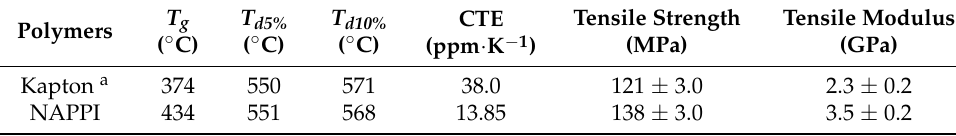
Figure 5. ( a ) Thermogravimetric analyses (TGA), ( b ) Dynamic mechanical analysis (DMA), and ( c ) Thermalmechanical analysis (TMA) curves of the NAPPI film. Table 1. Thermal and mechanical properties of the polyimide films.